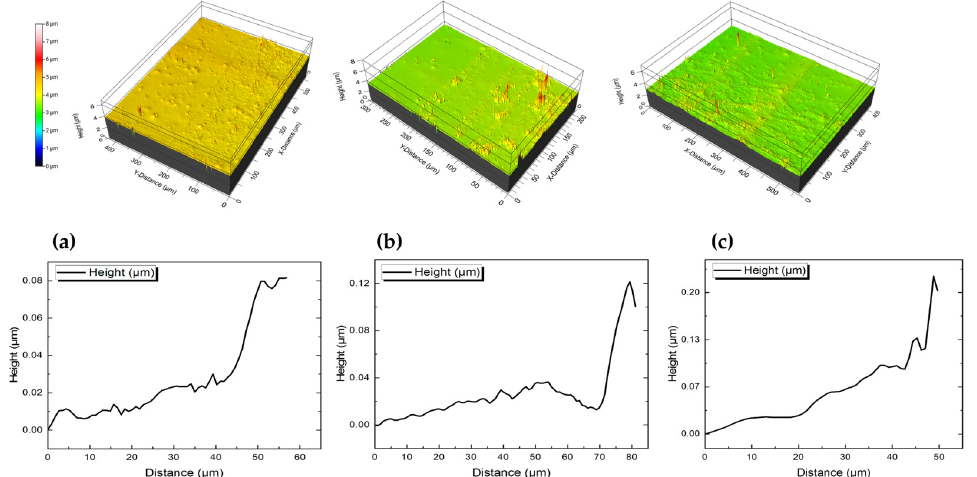
Figure 8. 3D height optical profile measurements for: ( a ) 2.5 wt%; ( b ) 5 wt%; ( c ) 10 wt%; f –rGO ink concentrations (top view and height profiles).